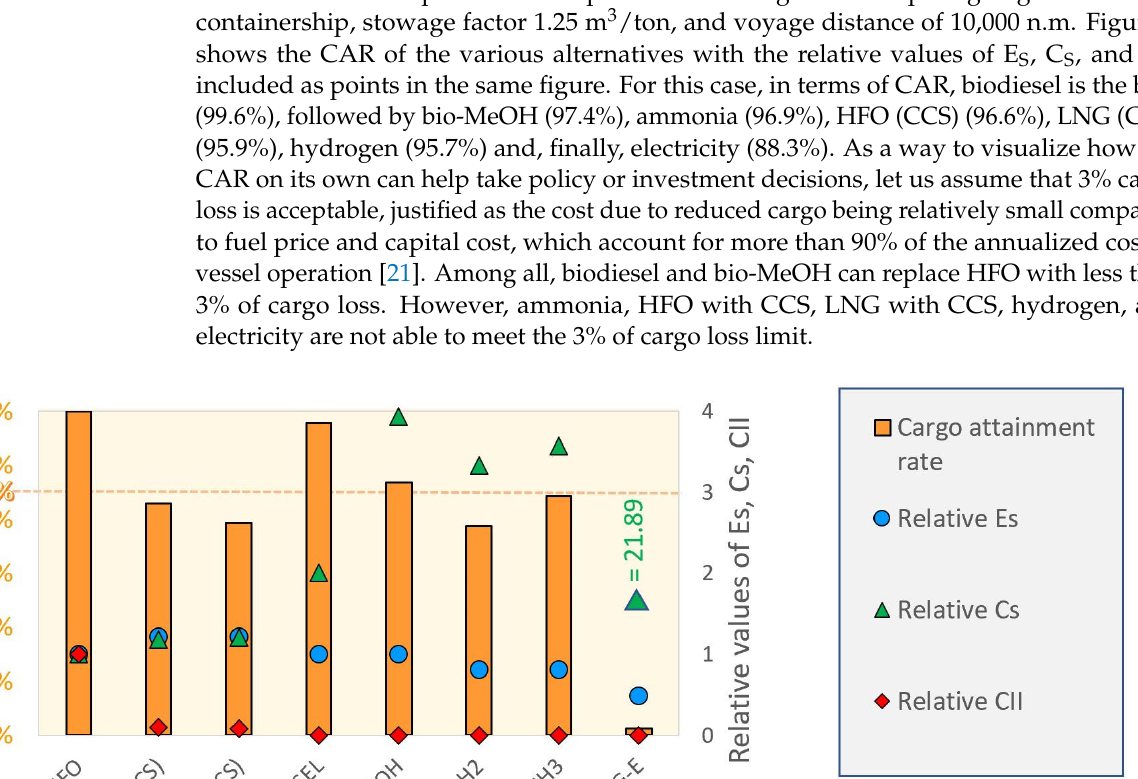
unit weight and distance, E S , economic cost (including fuel cost) per unit weight and distance C S , and